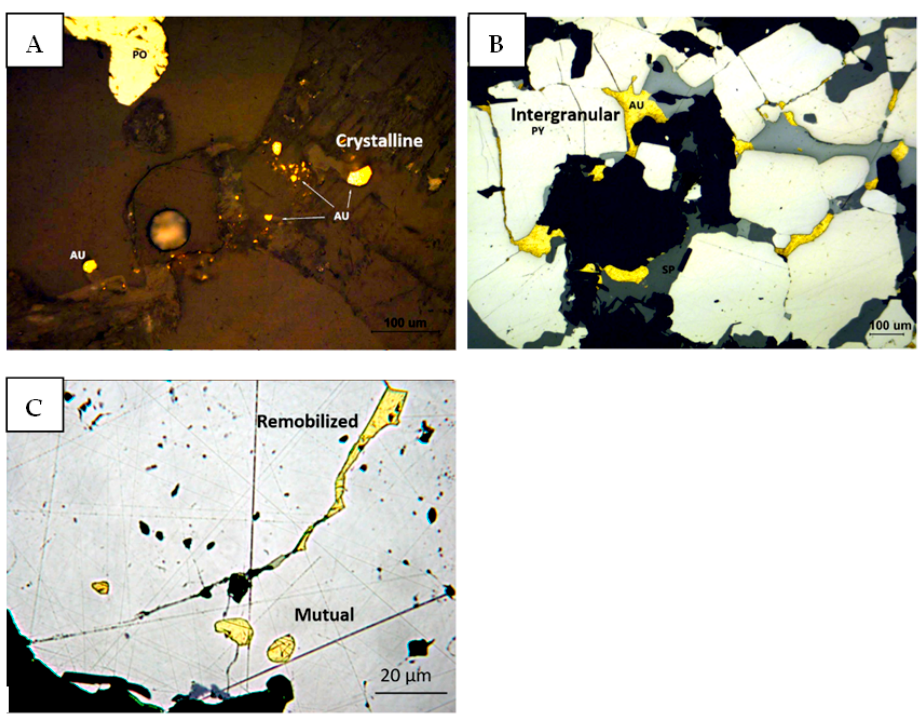
Figure 8. Examples of gold grain with the four main morphofacies as seen on a thin section with a petrographic microscope in reflected polarized light. ( A ) Crystalline grain in quartz. ( B ) Intergranular gold grain between pyrite, sphalerite and quartz. ( C ) Mutual gold droplet and remobilized leaflet in pyrite.